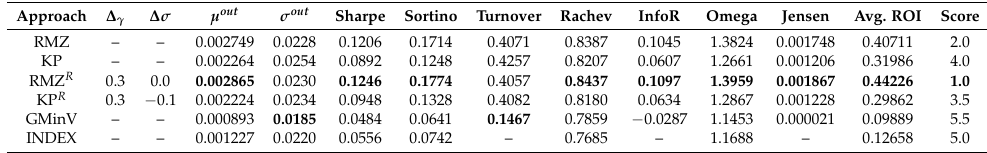
Table 15. Summary of results for